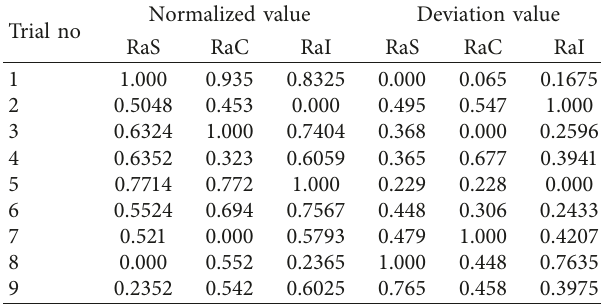
Table 5: Normalization and the deviation values during the GRA.